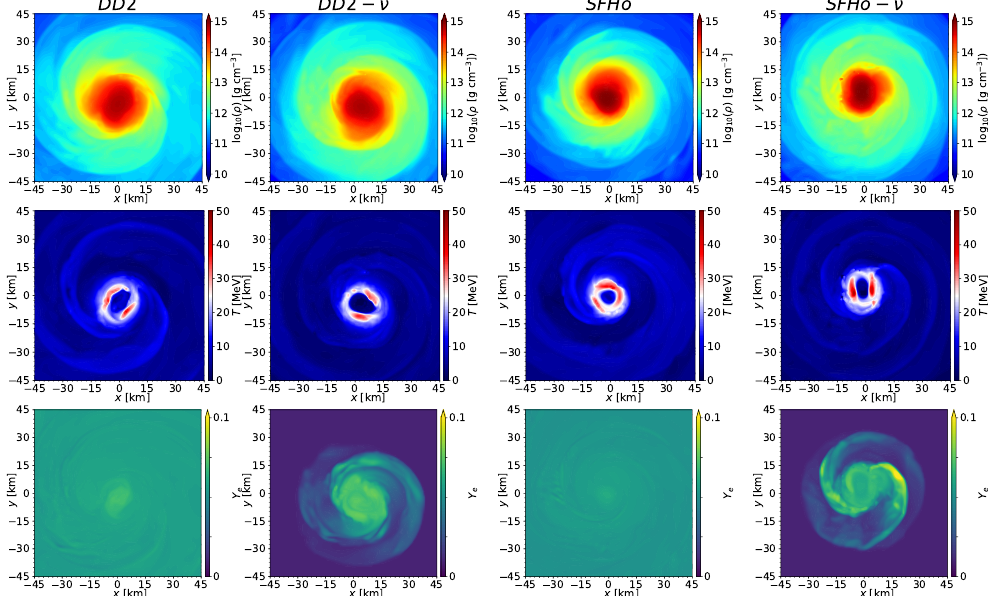
Figure 6. Snapshots of the remnant 10 ms after the merger in the x - y plane. From left to right: DD2, DD2- ν , SFHo, and SFHo- ν . From top to bottom: rest-mass density, temperature, and electron fraction. Overall, we note the formation of bar-like structures (see the extended ρ ≥ 10 13 g cm − 3 central regions and the ρ ≥ 10 12 g cm − 3 arms in the top panels) surrounded by dense disks. The temperature profiles exhibit a hot interface between the bar and the disk. Finally, the effects of the NLS are perceivable on the electron fraction, where the disk becomes more neutron-rich, as opposed to the cores and spiral